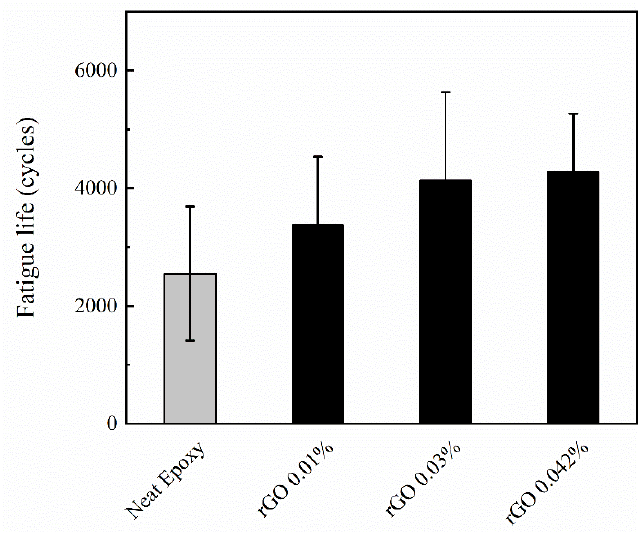
Figure 4. Effect of reduced-graphene oxide loading on fatigue life of multiscale GFRP nanocomposites.